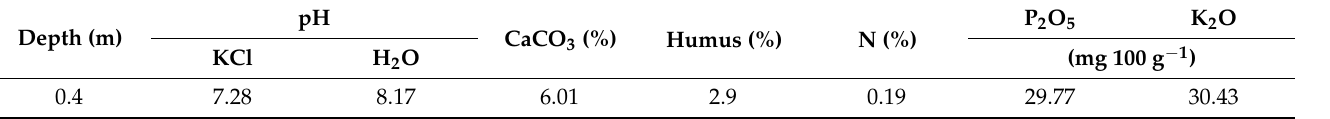
Table 2. Chemical properties of the